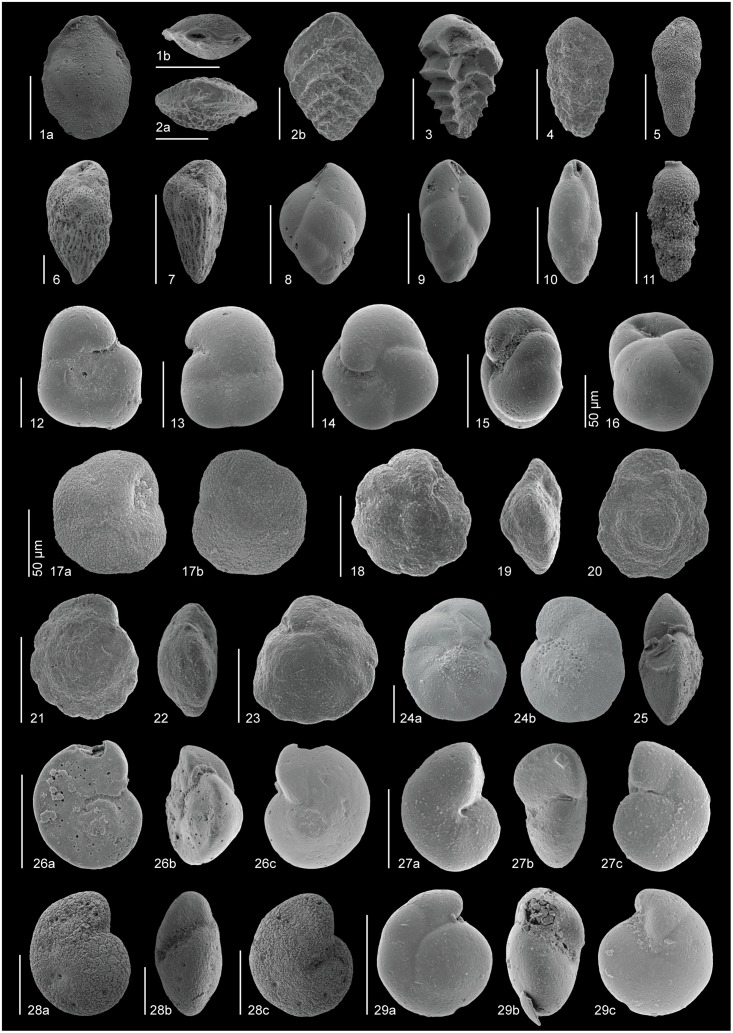
SEM images of some abundant Ypresian (lower Eocene) species.All scale bars represent 100 μm, unless otherwise indicated. 1, Seabrookia rugosa (sample 1258-14-4, 44–46 cm): a) lateral, b) apertural. 2, Aragonia aragonensis (sample 550-29-1, 8–10 cm): a) apertural, b) lateral. 3, Tappanina selmensis (sample 1258-14-4, 14–16 cm). 4, Bolivinoides decoratus (sample 550-29-4, 15–17 cm). 5, Bulimina elongata (sample 550-29-1, 52–54 cm). 6, Bulimina semicostata (sample 1051-48-1, 37–39 cm). 7, Bulimina virginiana (sample 1051-48-2, 75–77 cm). 8, Bulimina sp. 1 (sample 1258-14-4, 14–16 cm). 9, Bulimina sp. 1 (sample 1258-14-4, 14–16 cm). 10, Bulimina kugleri (sample 550-30-1, 106.5–108 cm). 11, Siphogenerinoides brevispinosa (sample 1258-14-CC, 5–7 cm). 12, Quadrimorphina profunda (sample 401-13-2, 43–45 cm): umbilical. 13, Quadrimorphina profunda (sample 550-29-5, 126.5–129 cm): ventral. 14, Abyssamina poagi (sample 550-30-1, 106.5–108 cm): umbilical. 15, Abyssamina poagi (sample 401-13-3, 43–45 cm): apertural. 16, Globocassidulina subglobosa (sample 550-29-6, 57–59 cm). 17, Epistominella exigua (sample 401-13-4, 130–132 cm): a) ventral, b) dorsal. 18, Nuttallides umbonifera (sample 550-29-5, 15–17 cm): ventral. 19, Nuttallides umbonifera (sample 550-29-5, 15–17 cm): apertural. 20, Nuttallides umbonifera (sample 550-29-1, 8–10 cm): dorsal. 21, Osangularia sp. 1 (sample 550-29-5, 15–17 cm): dorsal. 22, Osangularia sp. 1 (sample 550-29-4, 65–67 cm): apertural. 23, Osangularia sp. 1 (sample 550-29-2, 53–55 cm): ventral. 24, Cibicidoides praemundulus (sample 865-10-2, 4–6 cm): a) umbilical, b) dorsal. 25, Cibicidoides praemundulus (sample 865-10-2, 4–6 cm): apertural. 26, Cibicidoides proprius (sample 401-13-4, 130–132 cm): a) dorsal, b) apertural, c) ventral. 27, Gyroidinoides depressus (sample 865-10-2, 60–62 cm): a) ventral, b) apertural, c) dorsal. 28, Gyroidinoides planulatus (sample 550-29-1, 52–54 cm): a) dorsal, b) apertural, c) ventral. 29, Gyroidinoides complanata (sample 401-13-4, 130–132 cm): a) dorsal, b) apertural, c) ventral.